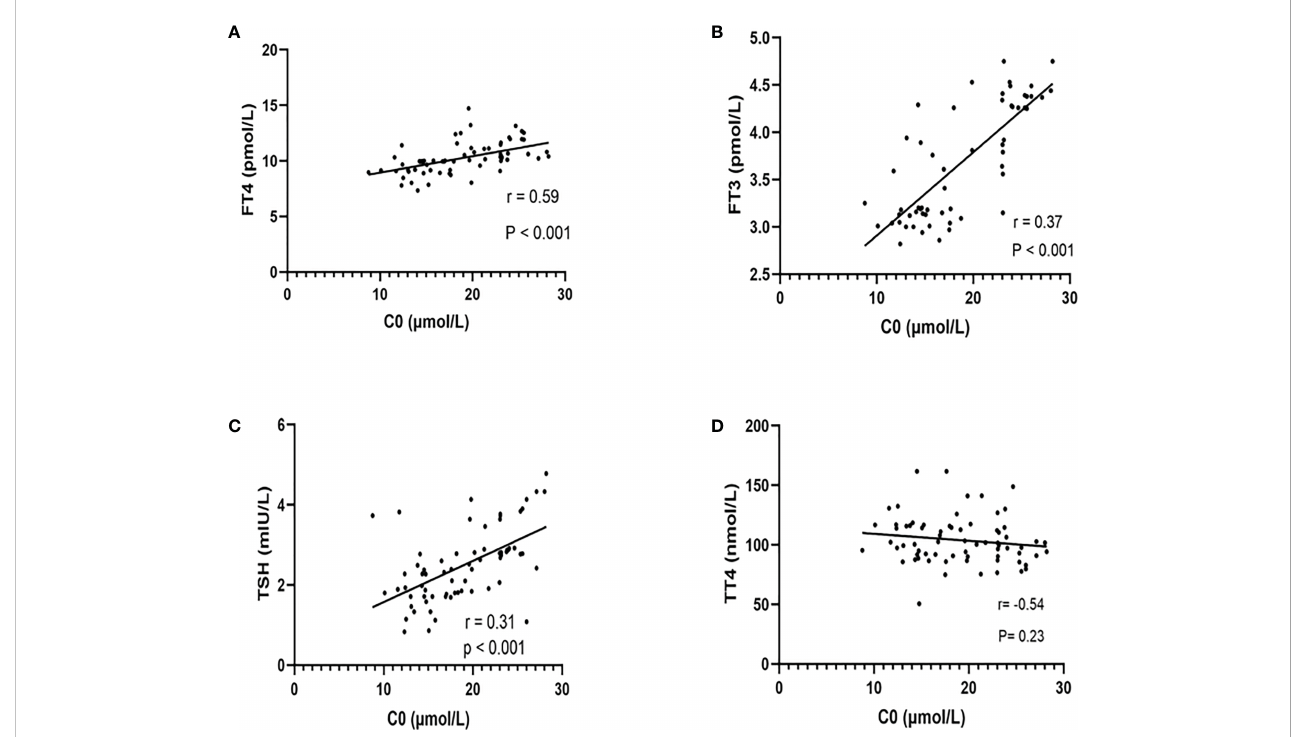
FIGURE 2 The relationship between free carnitine and thyroid hormones (FT4, FT3, TSH, and TT4). The correlation between C0 and FT4 (A) , FT3 (B) , TSH (C) , and TT4 (D) was shown above. There were signi fi cant positive correlations between C0 and FT4, FT3, and TSH rather than TT4. r = Spearman ’ s correlation coef fi